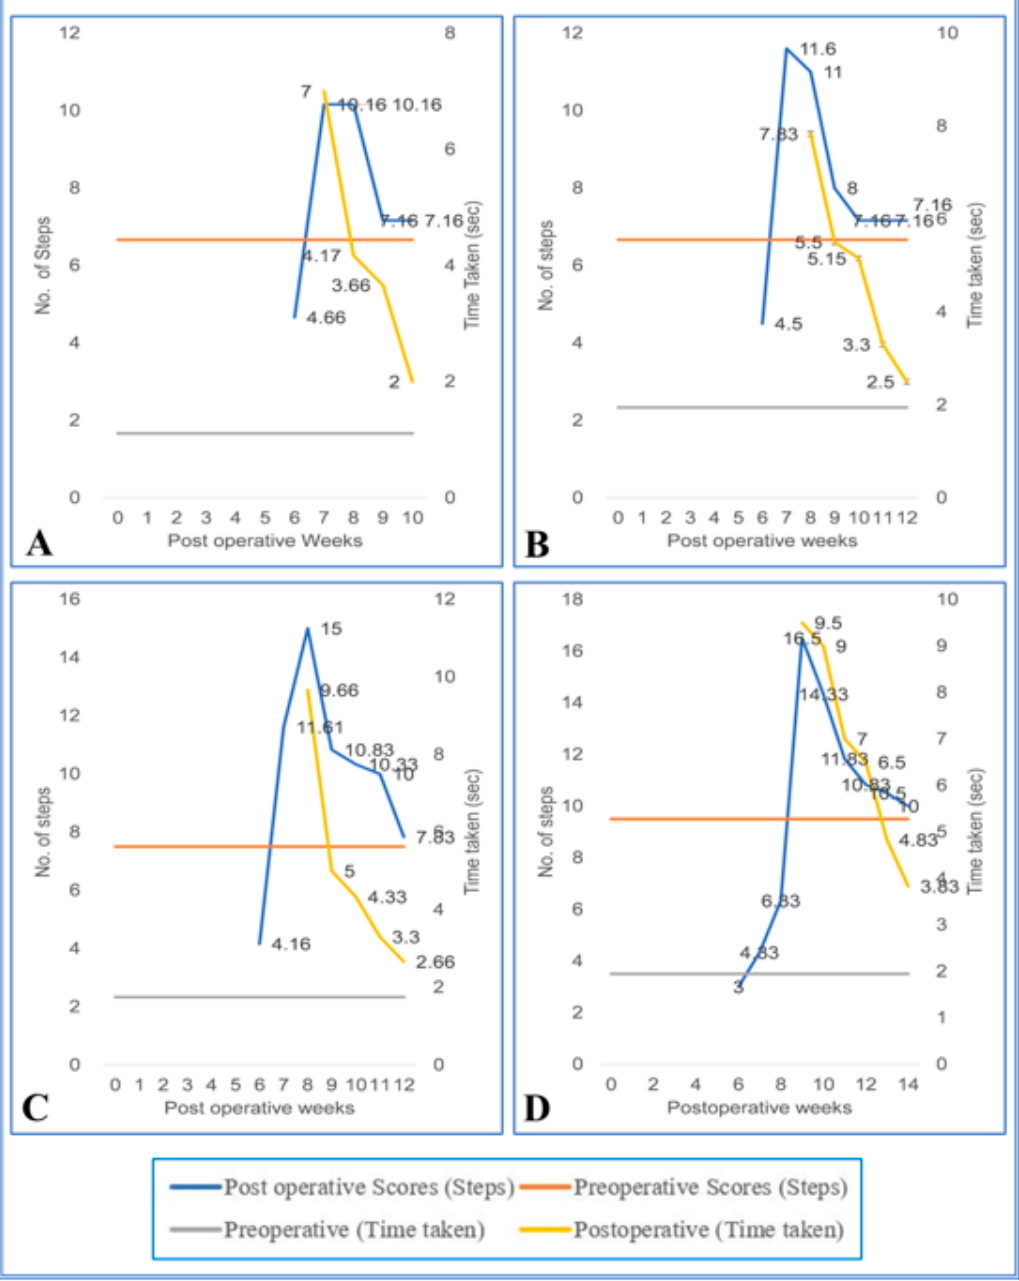
Figure 7. ( A – D ) Evaluation of locomotor behavior in grid runways after SPC hemisection in Bonnet monkey ( Macaca radiata ) on grid runways of 4, 5, 6, and and 7 cm intervals, respectively. Primary X-axis represents duration of recovery of locomotor functions in terms of weeks; primary Y-axis and secondary Y-axis represent the number of steps and time taken by the spinal cord unilateral hemisected monkeys to cross the grid runways.